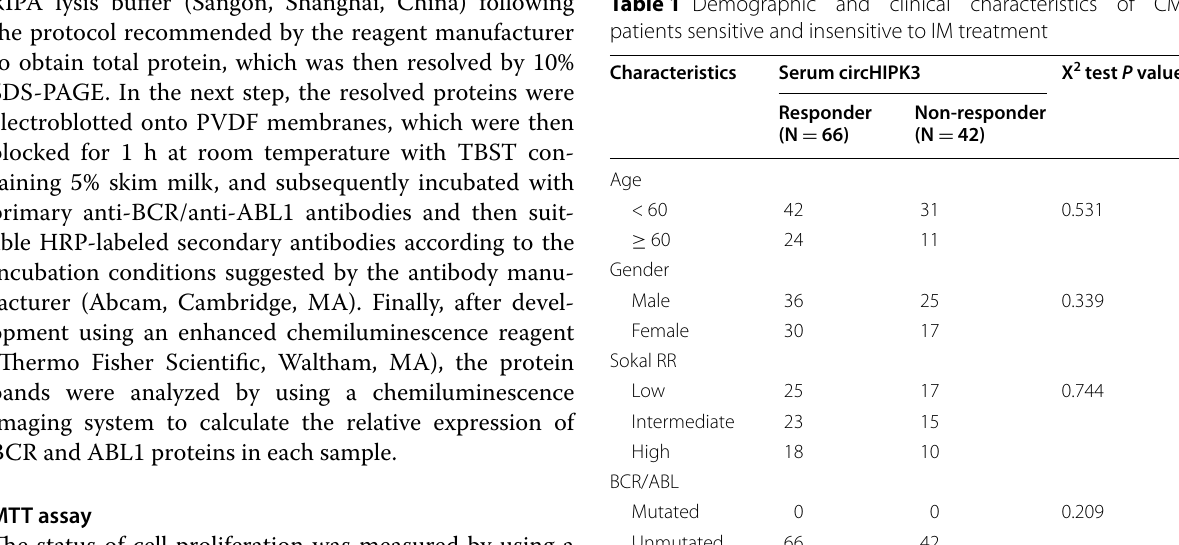
Table 1 Demographic and clinical characteristics of